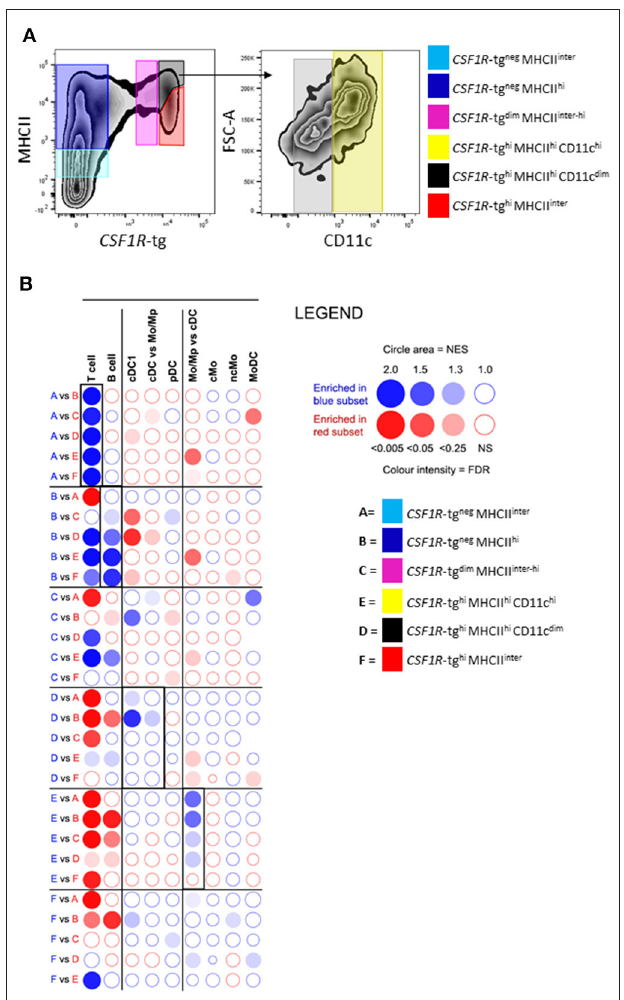
FIGURE 8 | The CSF1R -tg hi MHCII hi and CSF1R -tg hi MHCII inter cells are enriched with cells of the cDC and macrophage lineages. (A) FACS plot demonstrating the sorting strategy of the splenocytes subpopulations for RNA-seq analysis and the separation of the CSF1R -tg hi MHCII hi subpopulation into CD11c hi and CD11c dim cells; (B) GSEA-based analysis of immune cell signature enrichment in chicken spleen cell populations. The chicken spleen cell subpopulations were compared in pairs for their relative enrichment of mouse spleen immune cell signatures. Red and blue circles correspond to the enrichment of mouse immune cell gene sets in the cell population labeled with the same color. The bubble area is proportional to the normalized enrichment score (NES) calculated by GSEA. The intensity of the color corresponds to the FDR of the analysis.